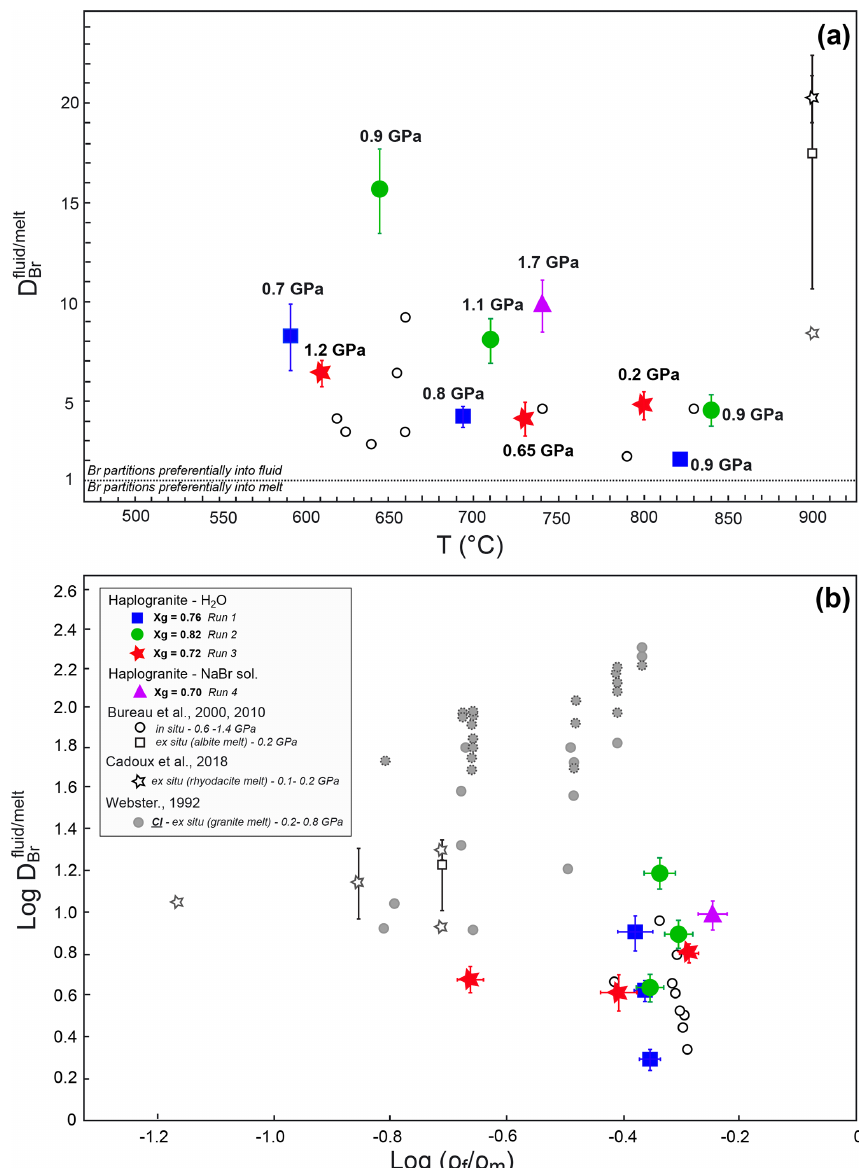
Figure 3. Evolution of the Br partition coefficients D f / m with (a) increasing temperature at different pressure conditions and (b) density ratio Br of coexisting fluids and melts for given P – T . The different symbols and colors account for separate experimental runs involving different glass proportions. The errors reported on D f / m take into account analytical uncertainties on the SXRF signal intensities in fluid and melt Br and an additional uncertainty of 10% on pressure determination. The Br and Cl fluid–melt partition coefficients from Bureau et al. (2000, 2010), Cadoux et al. (2018), and Webster (1992) are shown for comparison. For Cadoux et al., note that both average values from several = 20 . 2 ± 1 . 2) and the minimum value for a single experiment ( D f / m = 8 . 6) are reported. For Webster (1992), the solid experiments ( D f / m Br Br and dotted symbols are for experiments in which Cl in glass was <0.01wt% and 0.01wt%–0.03wt%,